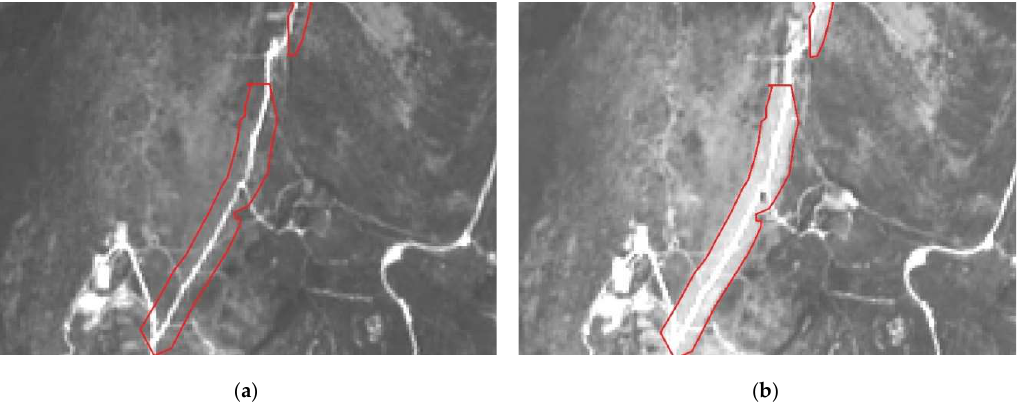
Figure 3. Example of a maintenance operation on an FB (red) in Serra dos Candeeiros, as seen by Sentinel-2 Band04 images. ( a ) before operation (08-05-2017); ( b ) after operation (04-07-2017).